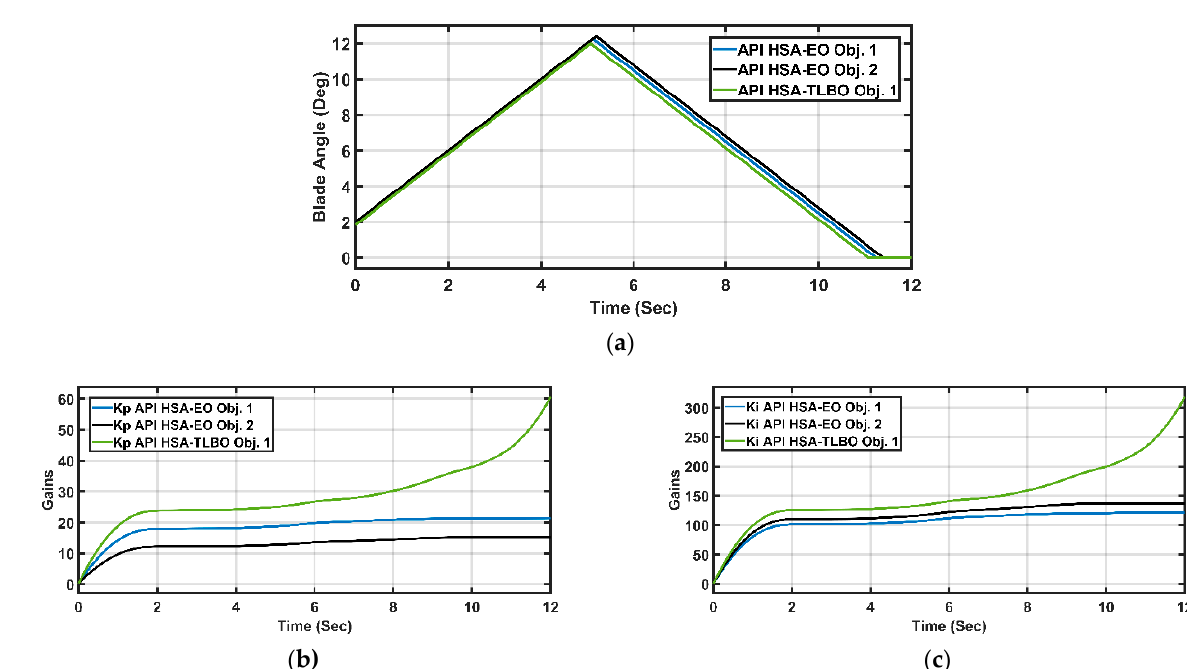
Figure 19. ( a ) Active power responses of normal third case. ( b ) Focusing active power responses of normal third case.